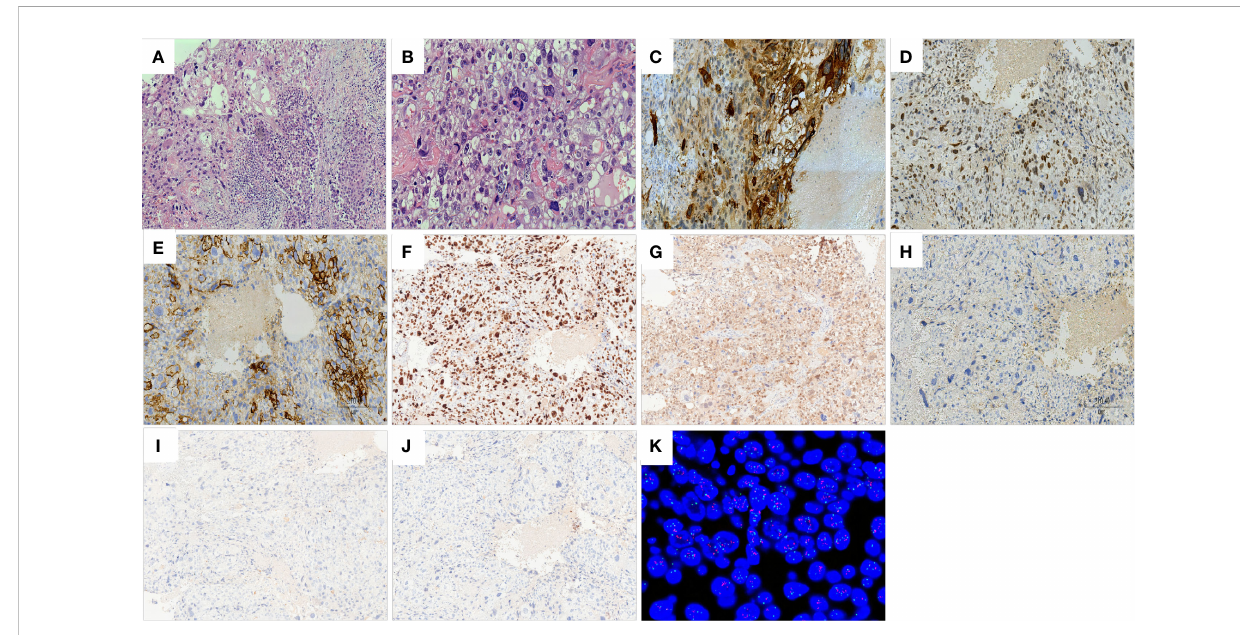
FIGURE 2 Histology of breast carcinoma with choriocarcinomatous features (BCCF). Hematoxylin – eosin staining (×100): close transition from the BIDC to the choriocarcinomatous areas (A) . Hematoxylin – eosin staining (×200): giant cells with prominent pleomorphic nuclei and abundant eosinophilic and vacuolated cytoplasm resembling cytotrophoblastic and syncytiotrophoblastic cells (B) . Immunohistochemistry of choriocarcinoma components (×100): HCG (C) , GATA3 (D) , HER2 (E) , KI67 (F) , P53 (G) are positive; ER (H) , PR (I) , AR (J) are negative. Fluorescence in situ hybridization (FISH): HER- 2 gene ampli fi cation (HER2/CEP17 ratio = 2.31) (K)